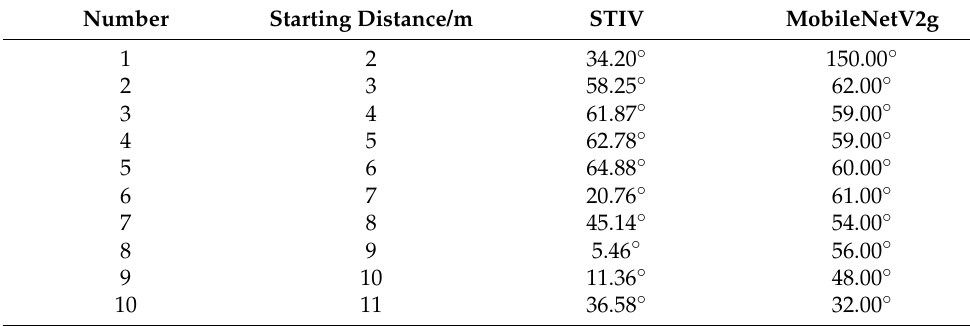
Figure 19. STIs and their FFT images obtained at Dali hydrographic Station. Table 12. Test results of